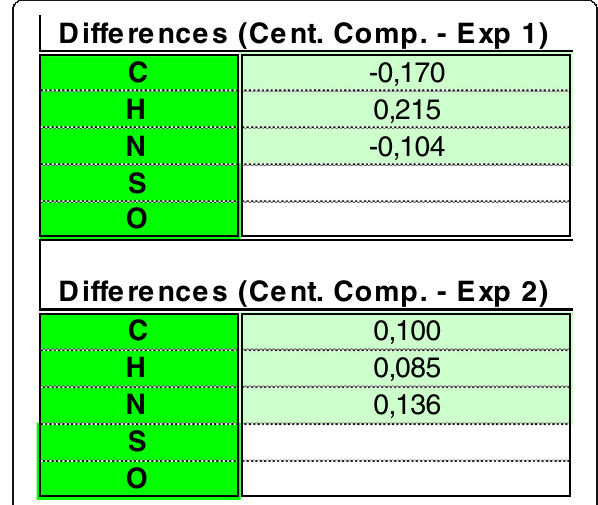
Fig. 4 User interface screenshot –– differences between recalculated centesimal composition and microanalysis experimental values